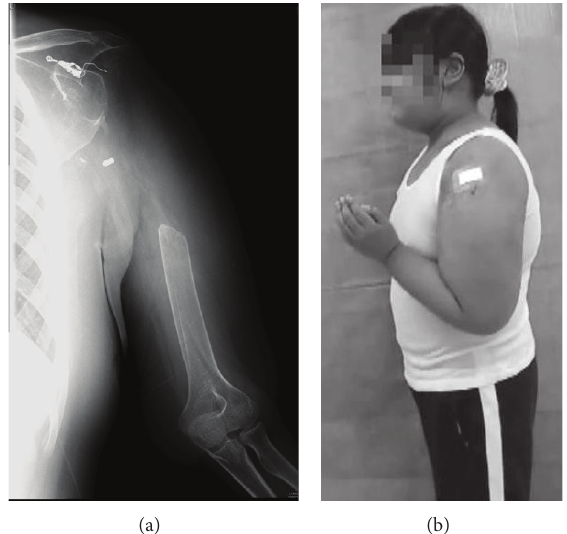
Figure 6: One-year postoperative radiograph showing the proximal humerus was resected and coils for preoperative embolization are left (a). Postoperative appearance of the left arm showing active elbow flexion